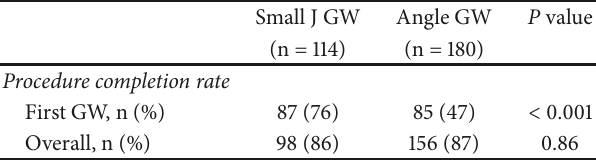
Table 2: Success rate of endoscopic